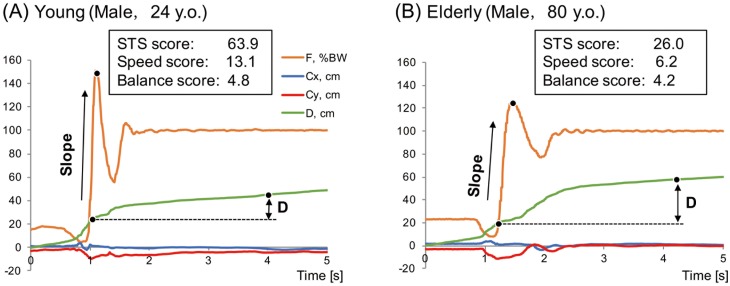
Typical graph patterns.Young (A) and elderly (B) participants in vertical reaction force, center of pressure (COP) position, and total COP distance.